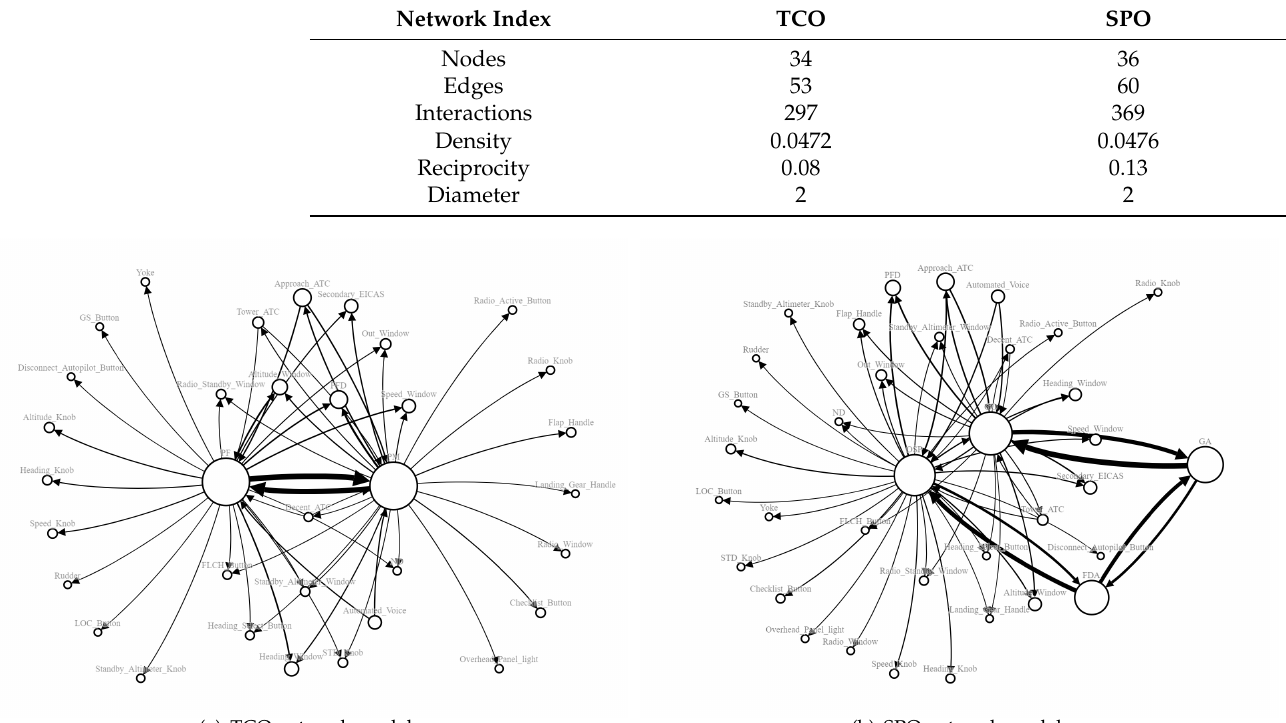
Figure 4. Two weighted directed network models transformed from TCO and SPO